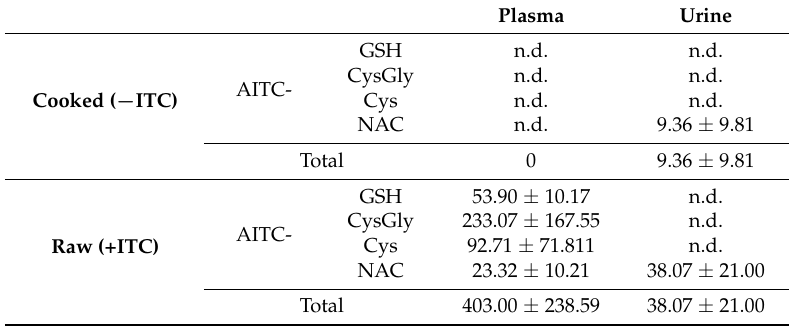
Table 1. AITC metabolites detected in plasma and urine of subjects ( n = 22) 2 h post-intervention.